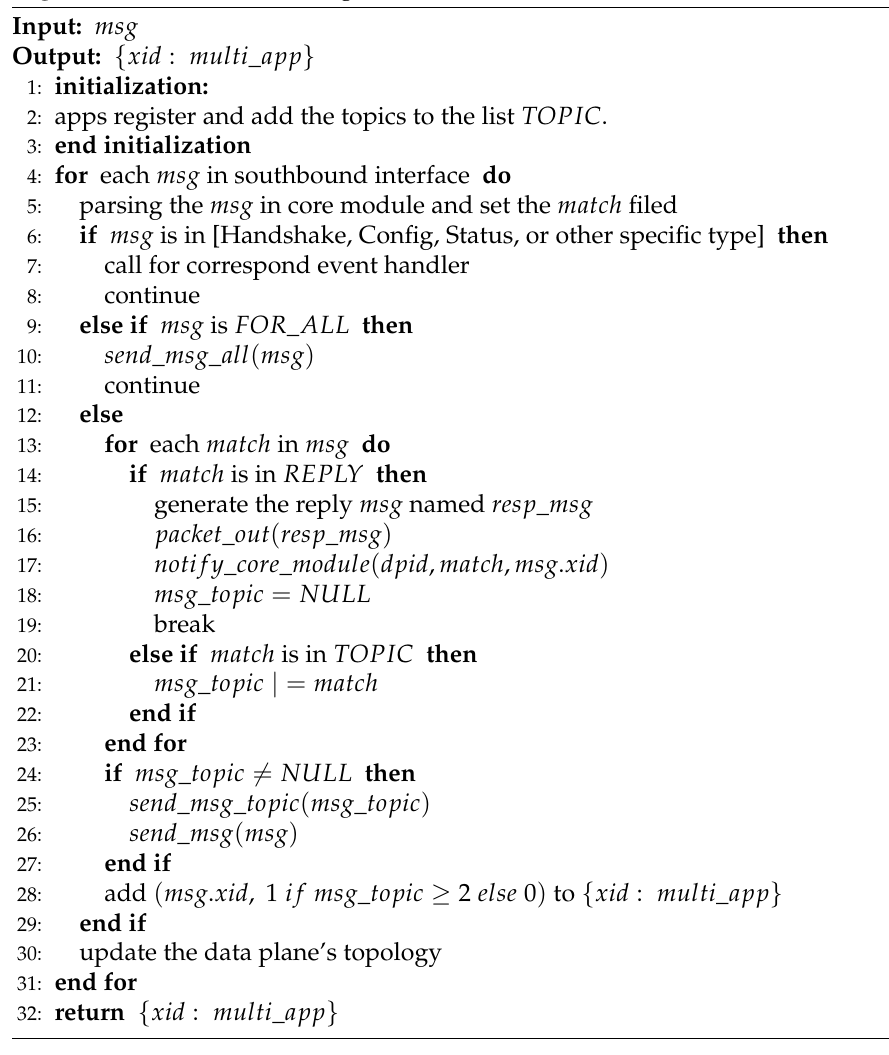
Algorithm 1 Enhanced Message Distribution